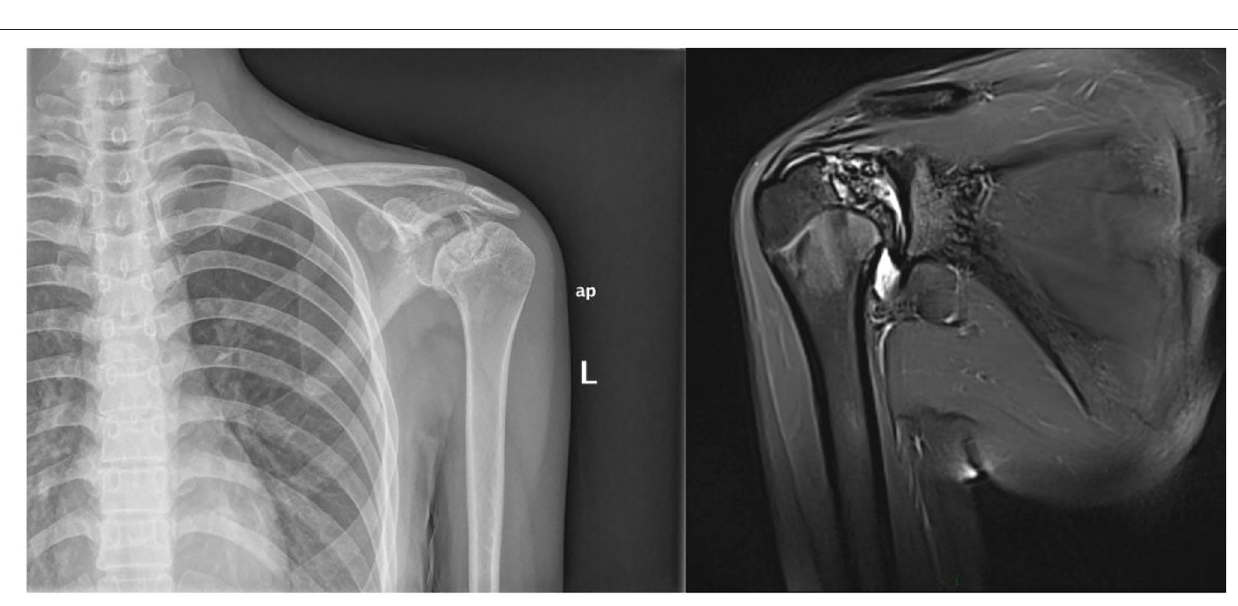
FIGURE 2 | A 20-year-old woman with a history of SLE for 2 years was diagnosed with humerus head